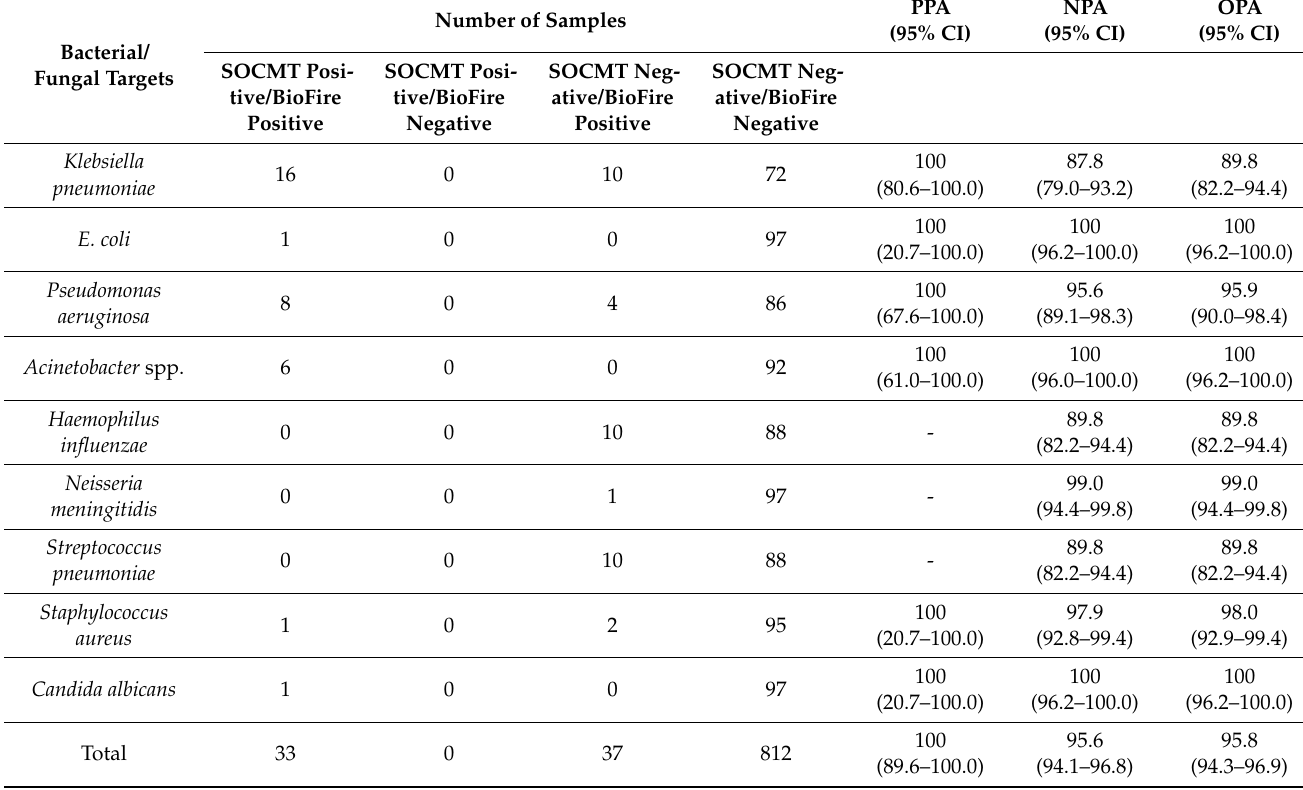
Table 6. Percent agreement between SOCMT and the BioFire FimArray for the detection of bacterial and fungal targets. ( n =